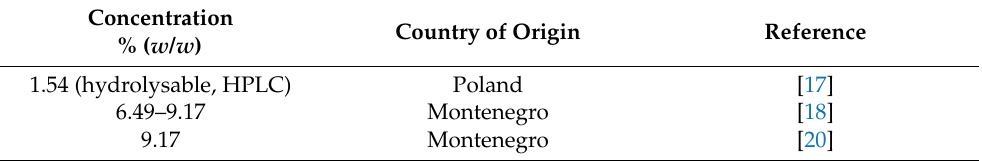
Table 3. Total tannin content reported in different studies.